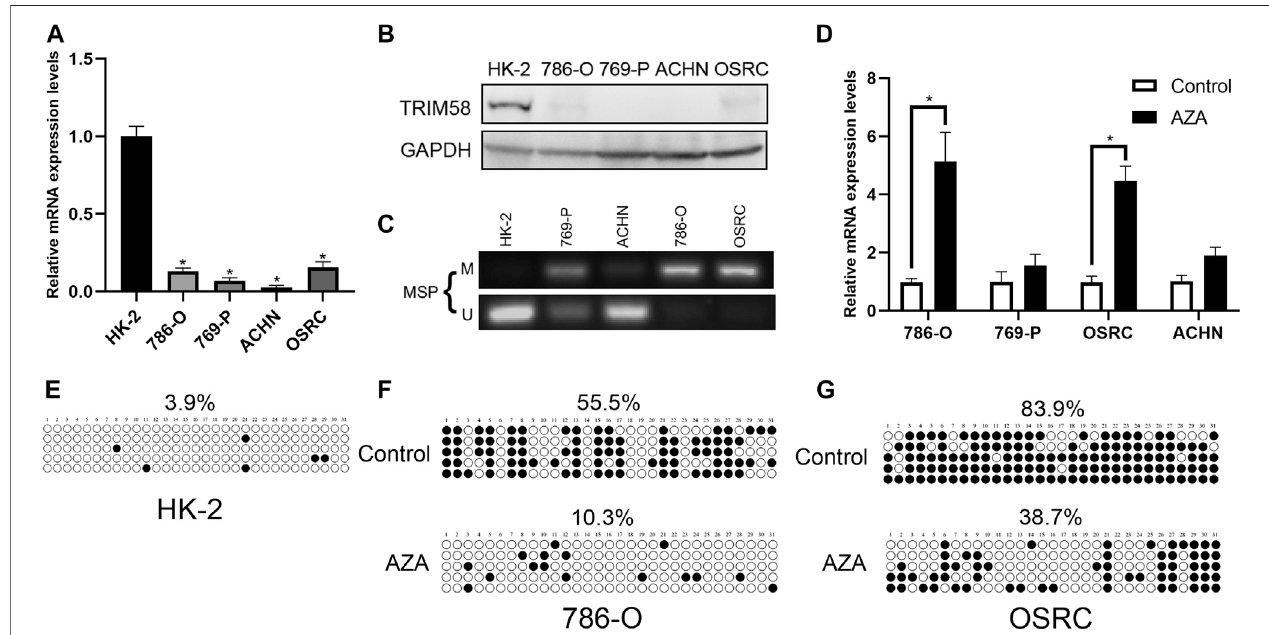
FIGURE2| TRIM58methylationcorrelates withits downregulation inRCC cell lines. (A , B) TRIM58expression in RCC celllines (786-O, 769-P,ACHN and OSRC) and HK-2 normal cells using qRT-PCR (A) and Western Blot (B) ; (C) MSP for methylation status of the TRIM58 promoter; (D) TRIM58 mRNA expression level after treating with the demethylation drug 5-AZA; (E) Methylation pattern of TRIM58 in HK-2 cells; (F , G) TRIM58 promoter CpG site methylation after treating with 5-AZA in 786-O and OS-RC-2